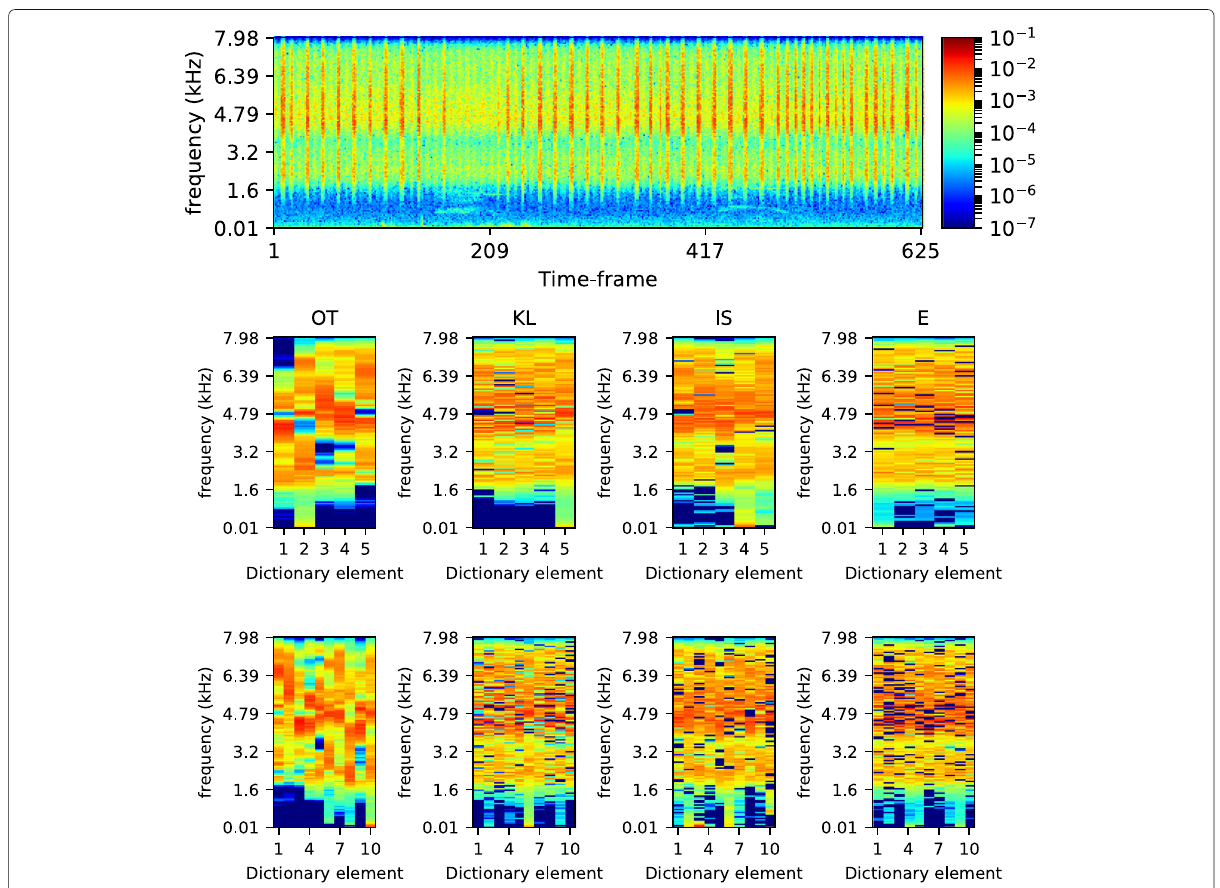
Fig. 9 Noise dictionaries. Dictionaries learned for the cicada noise. Top row: spectrogram of the training data. Middle and bottom row: dictionaries learned with respectively 5 and 10 elements, with the optimal transport, Kullback-Leibler, Itakura-Saito, and Euclidean loss (from left to